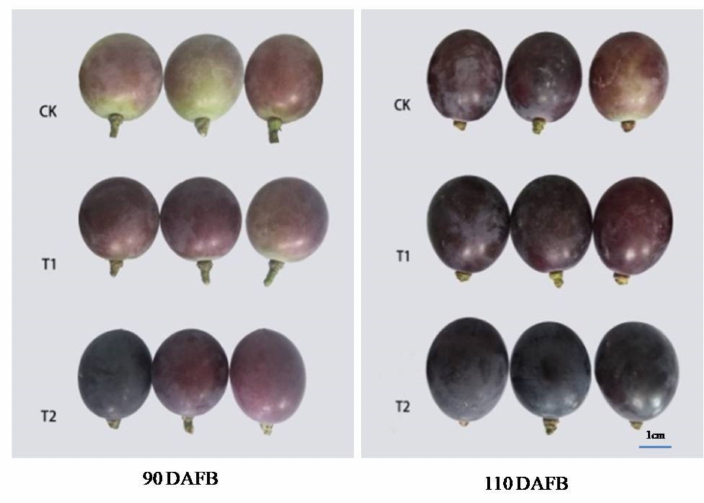
Figure 1. Visual color of ‘Kyoho’ grape berries at two